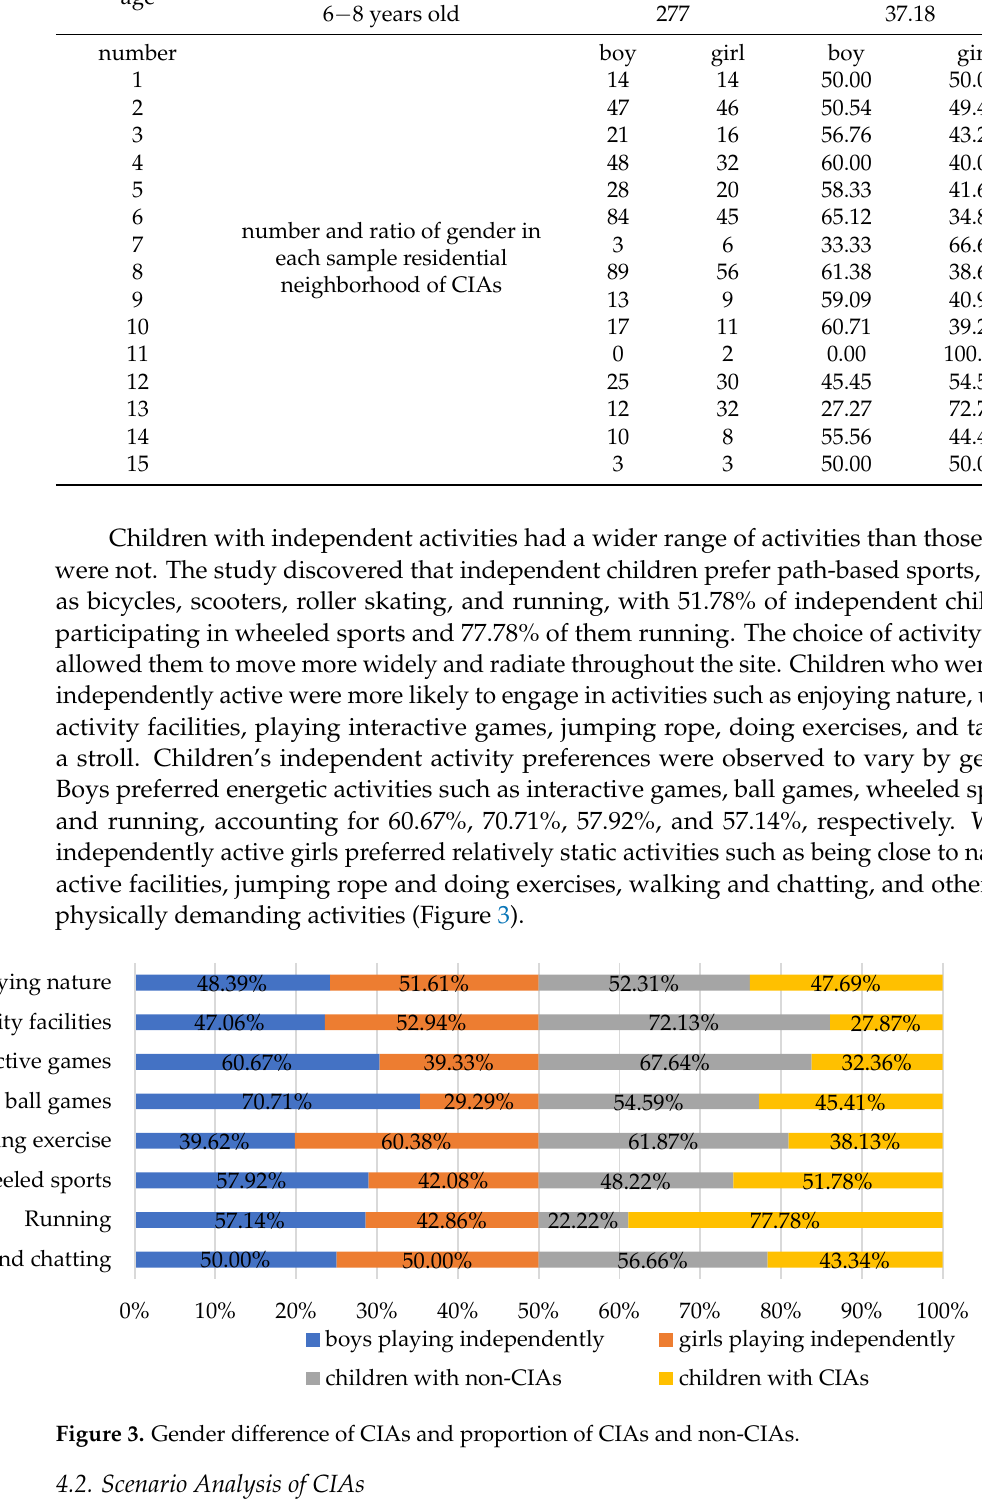
Table 4. Statistics on the age and gender differences of CIAs in sample neighborhoods.